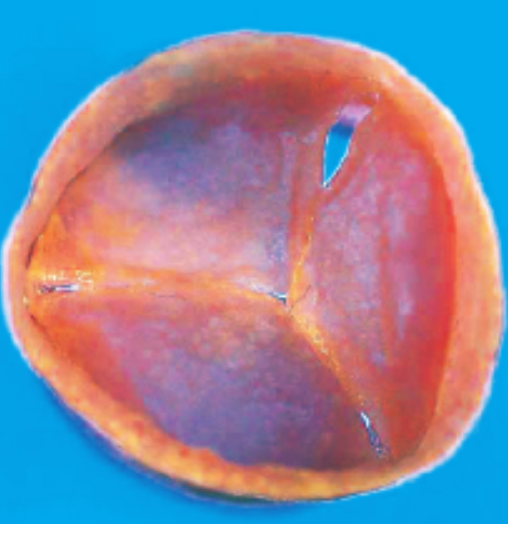
Figure 4 Umbilical cord blood- derived endothelial progenitor cells. 21 days after isola- tion, endothelial pro- genitor cells demon- strated cobble-stone morphology (A) and up-take for acetylated human Low Density Lipoprotein (ac-LDL; B). Furthermore, cells showed endothelial phenotype